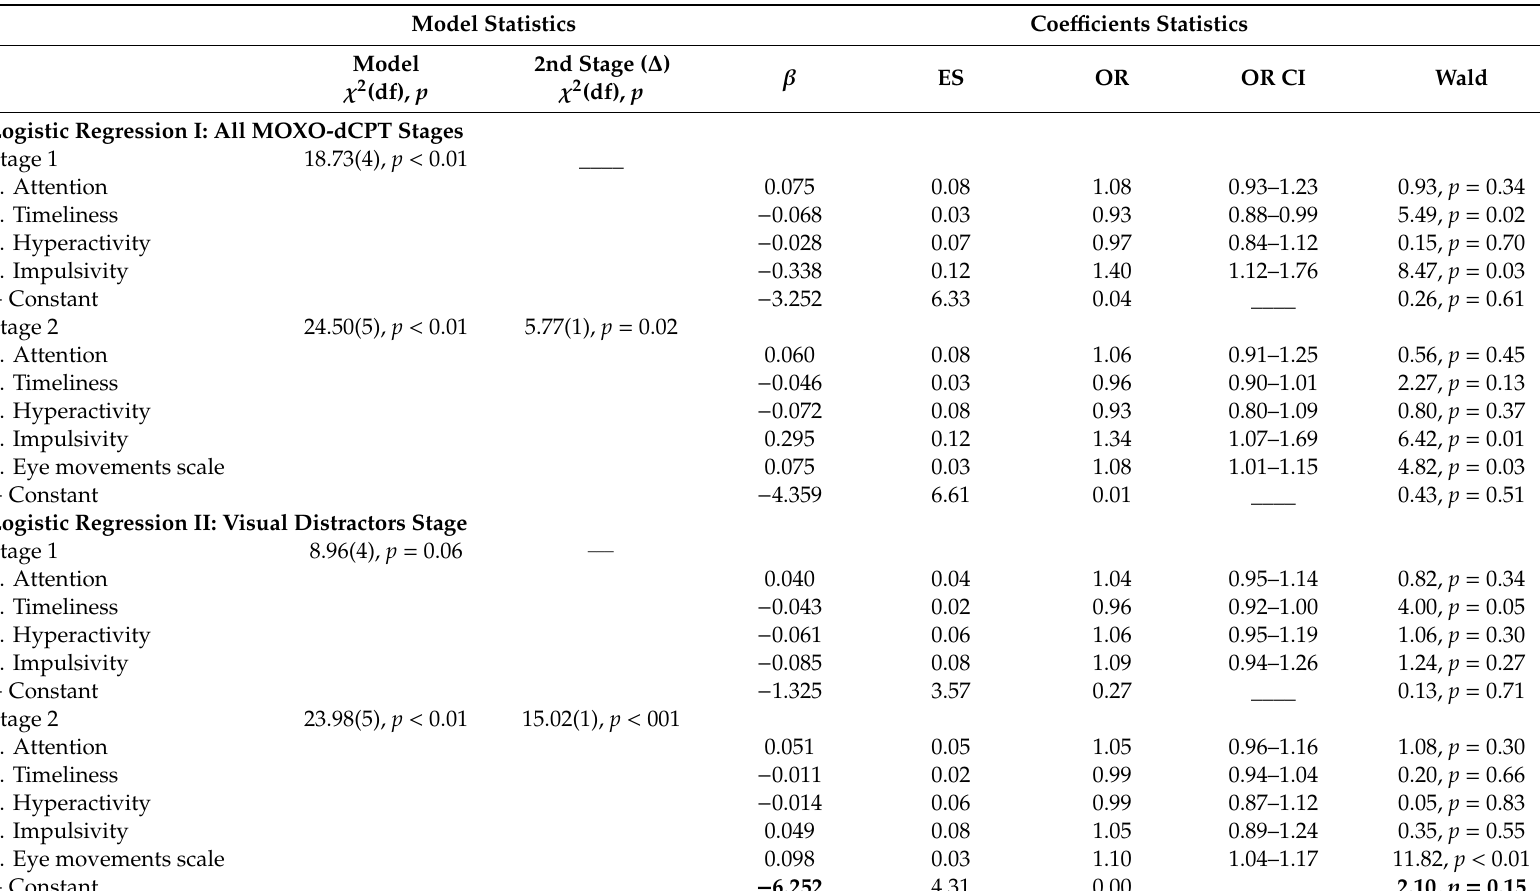
Table 3. Two-stage hierarchical logistic regressions ( N = 85), for all MOXO-dCPT stages and the visual distractors stage. The first model includes the four conventional indices and the second model adds the eye movement distractibility